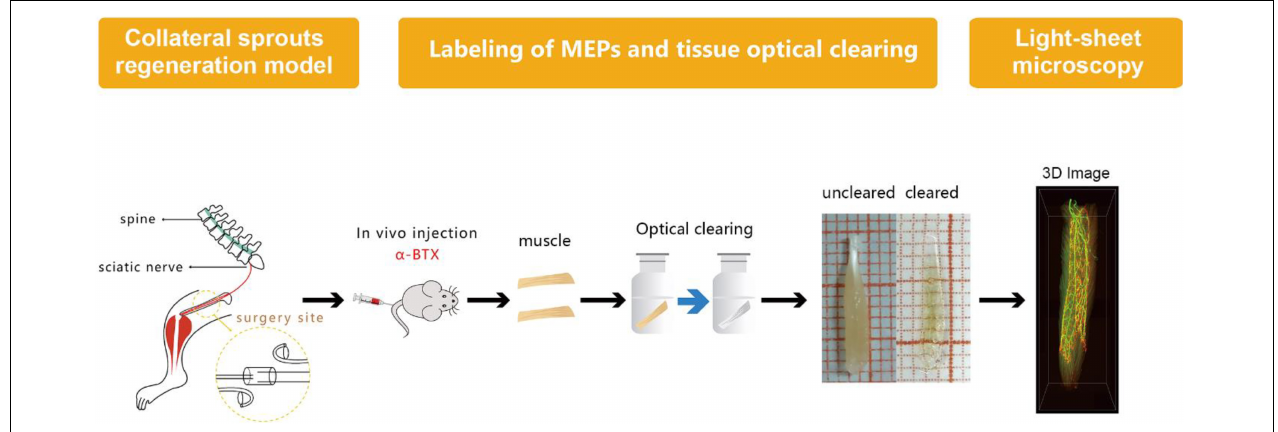
FIGURE 2 | Diagram of labeling of MEP, tissue optical clearing, and light-sheet microscopy. MEPs were labeled using α -bungarotoxin at 3 months after the surgery. Then, the long flexor digitorum was subjected to the optical clearing to obtain three-dimensional (3D) images of MNTs and MEPs using light-sheet